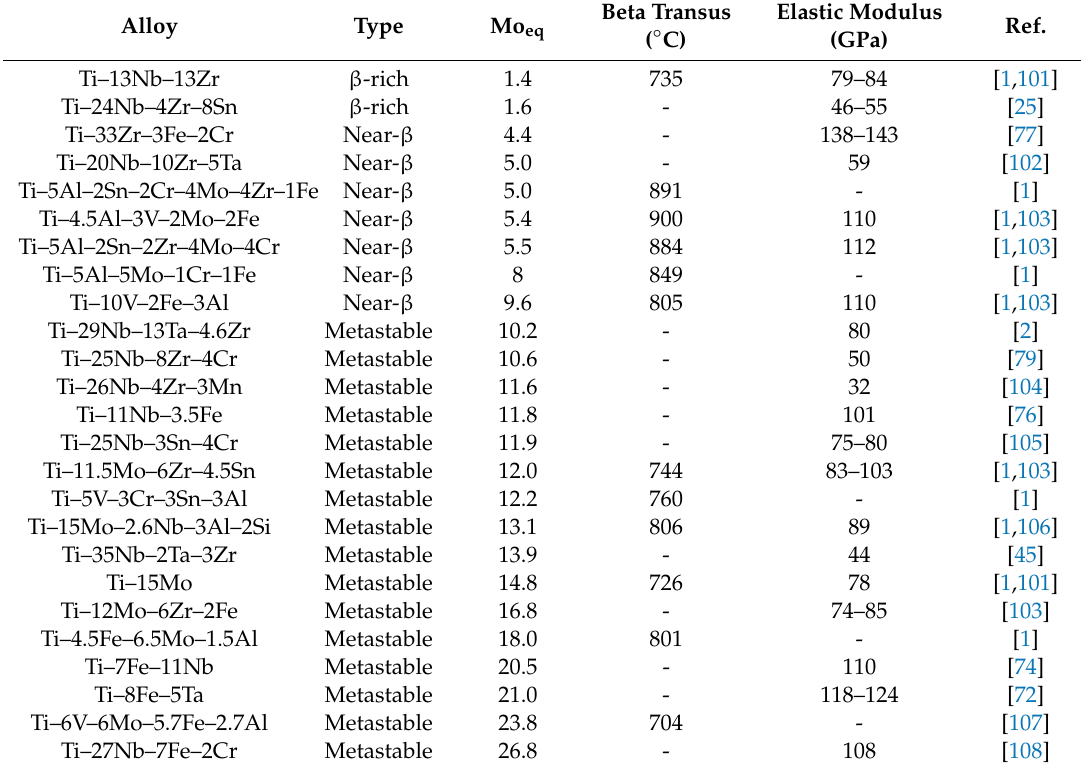
Table 1. Molybdenum equivalency (Mo eq ), β transus temperatures, and elastic modulus of some commercially β -Ti alloys and newly designed low-cost β -type Ti